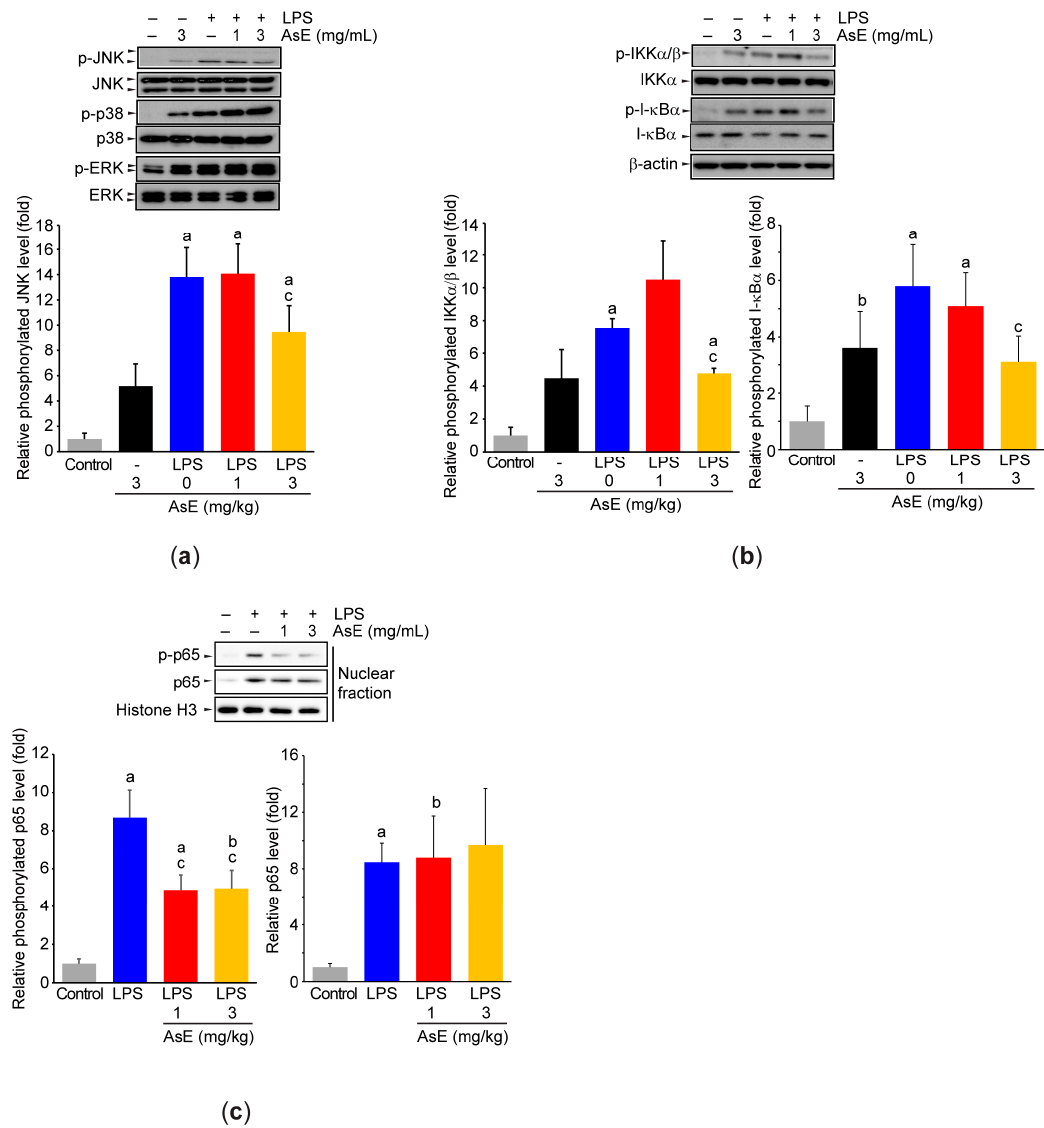
Figure 7. AsE blocks JNK and NF- κ B signaling pathways in LPS-stimulated Raw264.7 cells. Whole-cell lysates ( a , b ) and nuclear fraction were prepared after AsE (1 or 3 mg/mL)-pretreated Raw264.7 cells were subsequently exposed to the LPS (1 µ g/mL) for 1 h. Changes in mitogen-activated protein kinases ( a ) and NF- κ B signaling molecules ( b , c ) were monitored by immunoblot analysis. Equal protein loading was verified by immunoblotting of unphosphorylated protein (for ( a )), β -actin (for ( b )), or histone H3 (for ( c )). a p < 0.01, b p < 0.05 versus control cells; c p < 0.05 versus LPS-treated cells; ERK, extracellular signal-regulated kinase; p-ERK, phosphorylated ERK; I- κ B α , inhibitory- κ B α ; p-I- κ B α , phosphorylated I- κ B α ; IKK, I- κ B kinase; p-IKK, phosphorylated IKK; JNK, c-jun N-terminal kinase; p-JNK, phosphorylated JNK; p-p65, phosphorylated